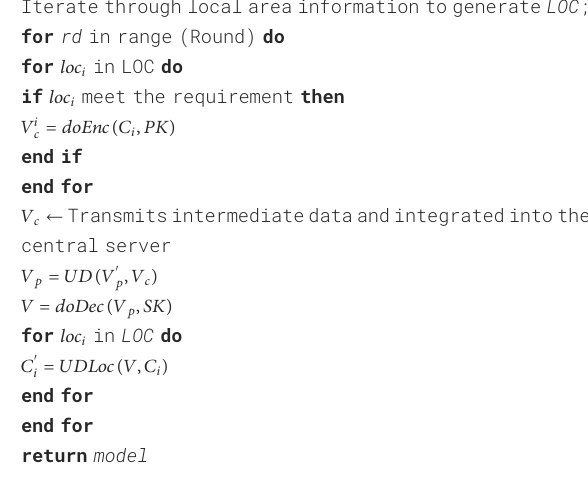
Algorithm 1. The model with federated learning.